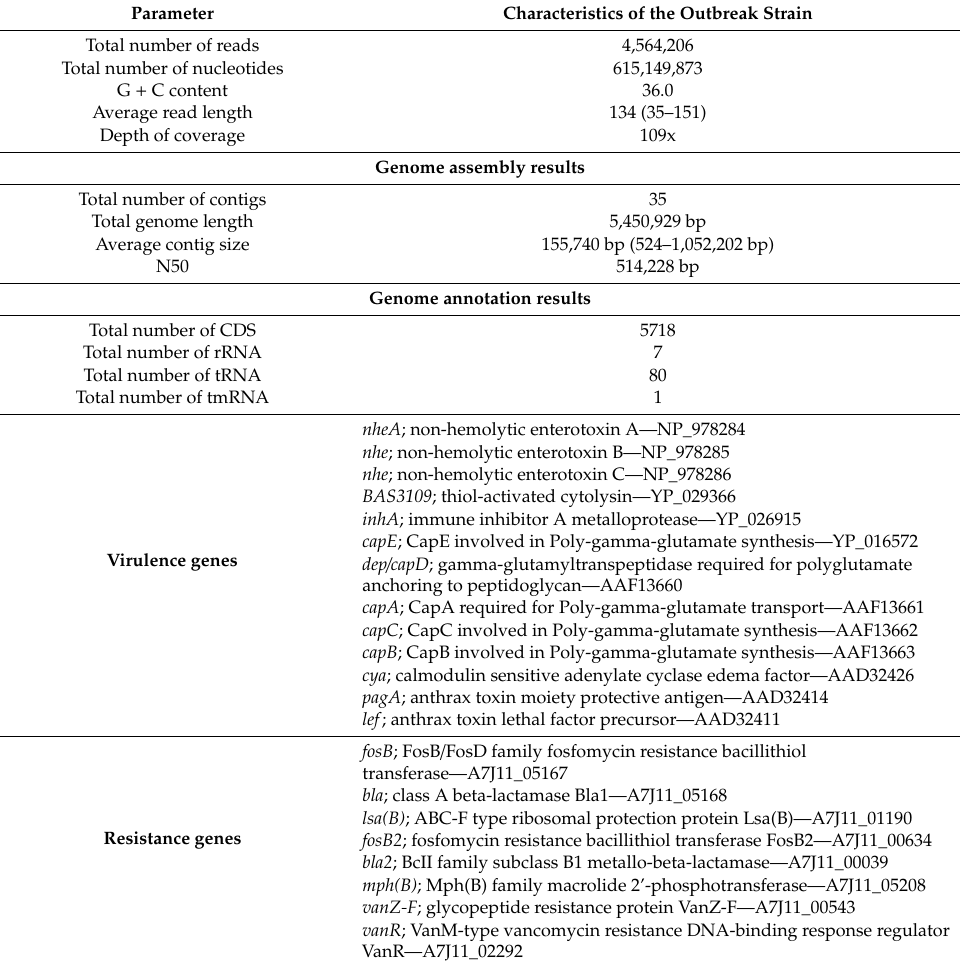
Table 1. Genomic feature of outbreak